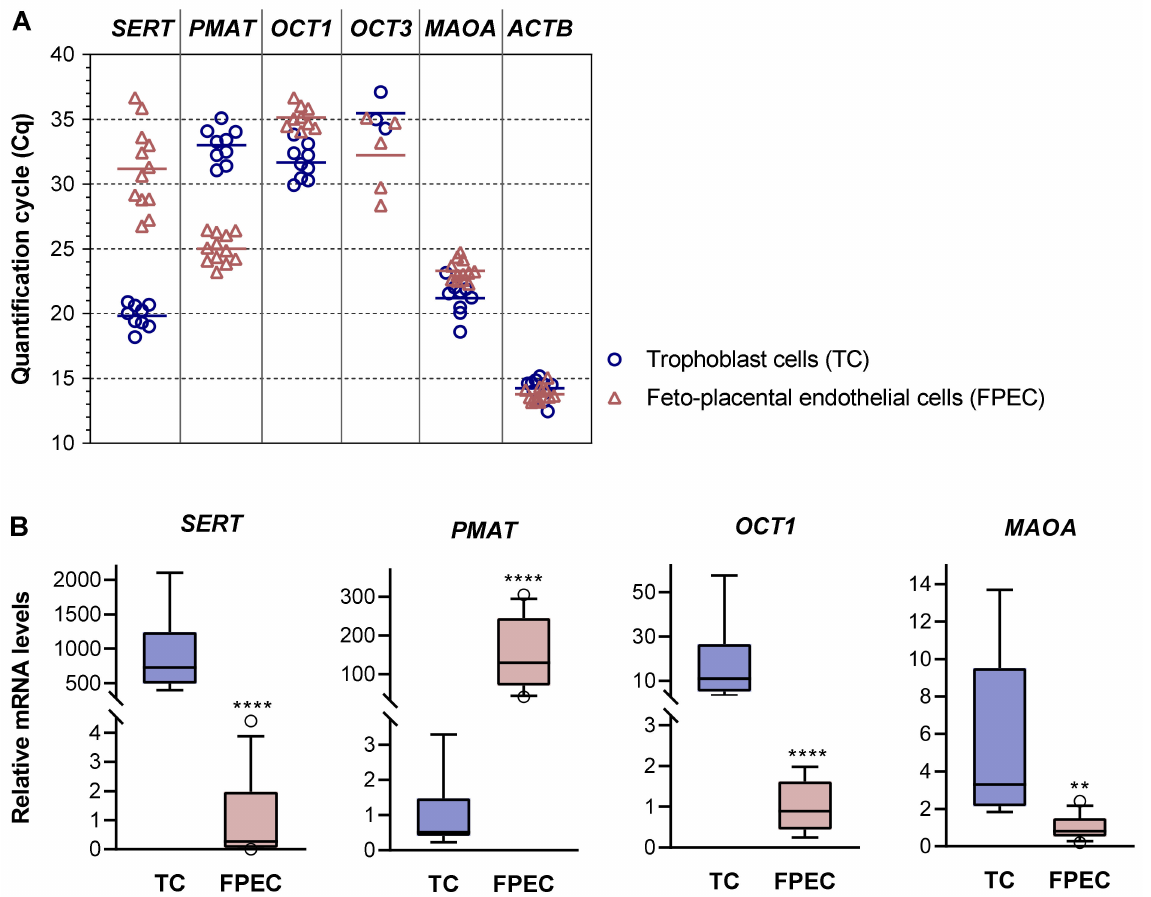
Figure 4. Expression of 5-HT regulating genes in primary placental cells. ( A ) Quantification cycle (Cq) values obtained by RT-qPCR analysis of serotonin transporter ( SERT ), plasma membrane monoamine transporter ( PMAT ), organic cation 1 ( OCT1 ), organic cation 3 ( OCT3 ), monoamine oxidase A ( MAOA ), and actin beta ( ACTB ) mRNAs in human primary trophoblasts (n = 9) and feto-placental endothelial cells (n = 12). A specific OCT1 signal was detected in 9 of the 12 feto- placental endothelial cell samples analyzed. A specific OCT2 signal was absent in all trophoblast and feto-placental endothelial cell isolations. A specific OCT3 signal was detected in 3 of 9 trophoblast and 5 of 12 feto-placental endothelial cell samples. For numerical results, see Table S2. ( B ) Relative expression levels of SERT , PMAT , OCT1 , and MAOA mRNAs normalized to ACTB mRNA. For each gene, the mean of the cells with the lower expression level was arbitrarily set to 1.00. Data are presented as boxplots with whiskers indicating the 10th and 90th percentiles and circles showing individual values outside the whisker range (n = 9 for TC; n = 12 for FPEC, except for OCT1 where n = 9). ** p < 0.01, **** p < 0.0001 ( t -test or Mann–Whitney test, as